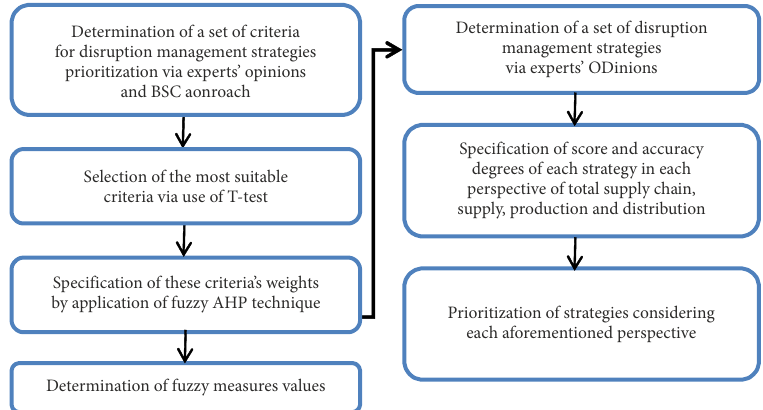
Fig. 1. Main steps of this study